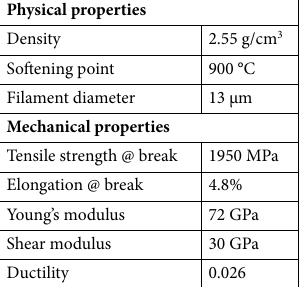
Table 1. Mechanical and physical properties of reinforcement glass fibers (GF).